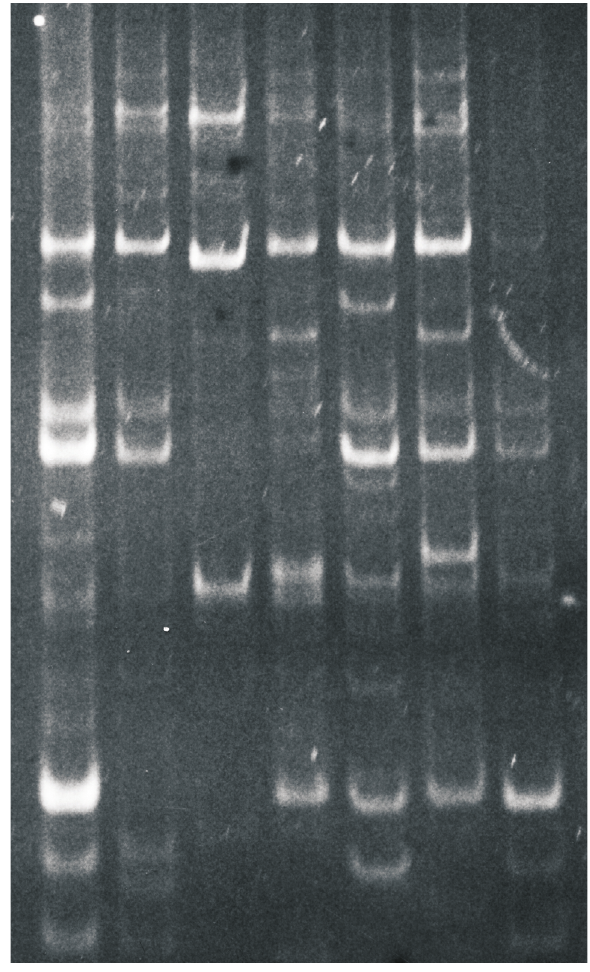
Figure 1 - PCR Product of marker SCJLRZ1018H04.g. Seize Marker: 50 kbladder;1=SP80-4966,2=SP80-180,3=IJ76-418Red,4=IM76-229,